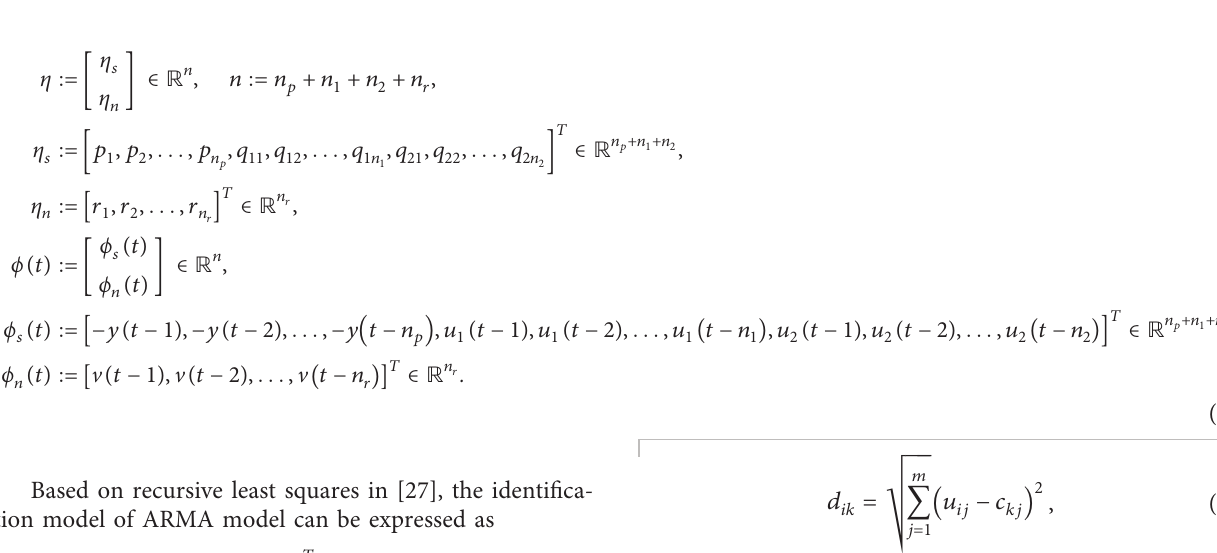
Figure 1: Two-input single-output autoregressive moving average